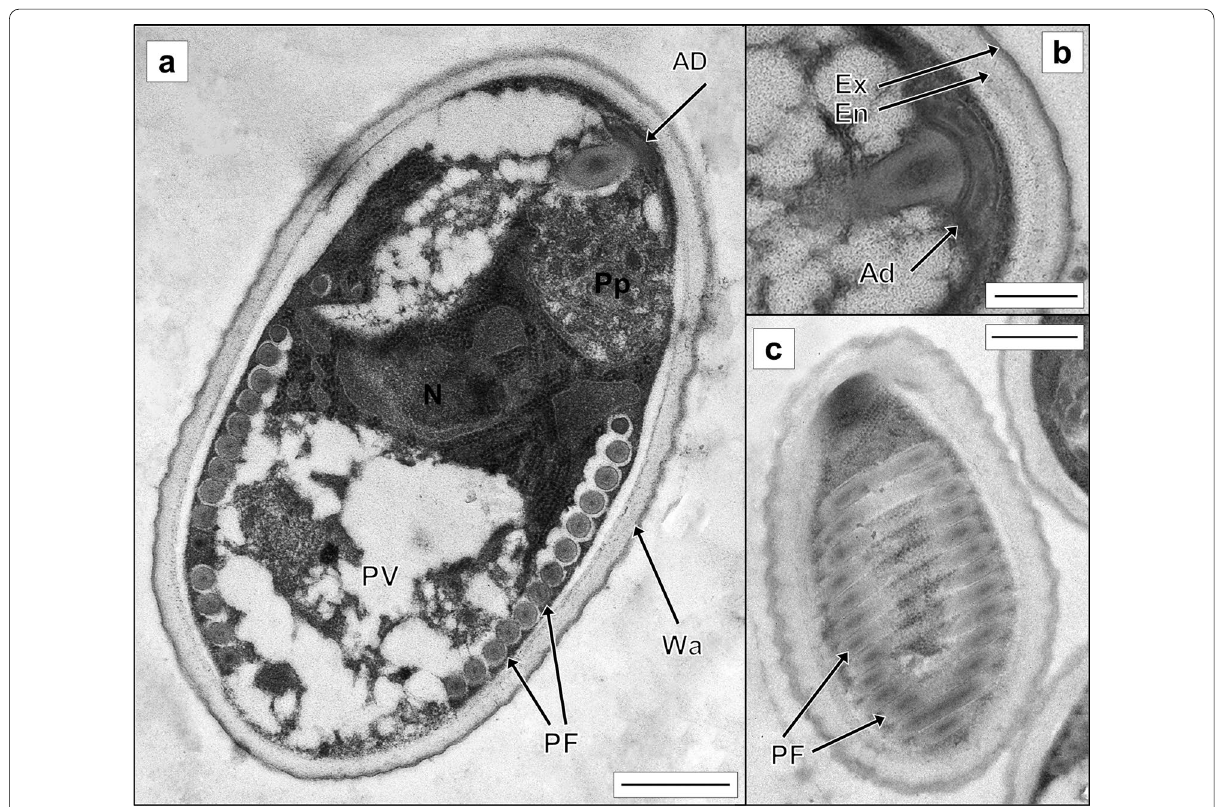
Fig. 4 Transmission electron micrographs of Glugea thunni from the caecal mass of Thunnus thynnus from the Mediterranean Sea. a Longitudinal section of an adult microspore showing the ultrastructure (scale bar 500 nm). b Detail of the anchoring disk and spore wall (scale bar 400 nm). c Detail of polar filament surrounding the spore (scale bar 1 µm). Abbreviations: AD—anchoring disk; En—wall endospore; Ex—wall exospore; N— spore nucleus; PF—polar filament; Pp—polaroplast; PV—posterior vacuole; Wa—spore